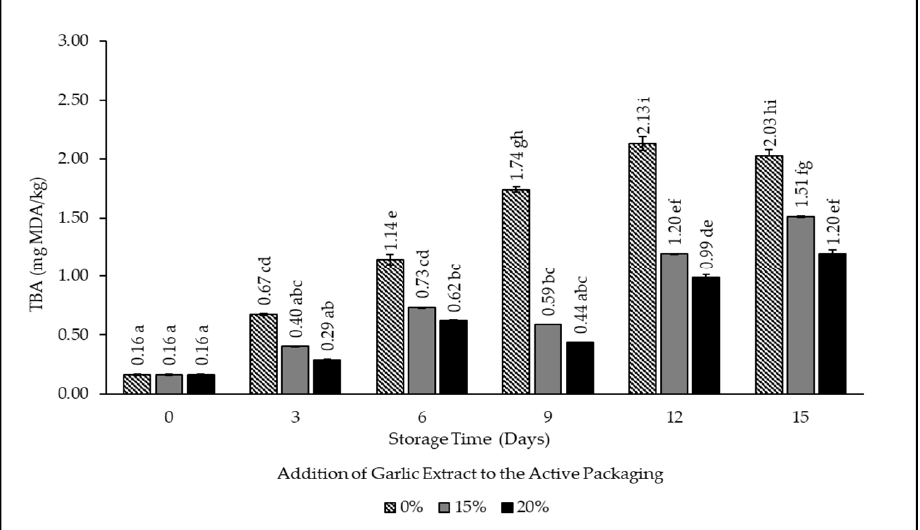
Figure 4. TBA value of beef packaged using intelligent and active packaging with the addition of garlic extract. T he mean value followed by various letters indicates a significant difference ( p < 0.05).